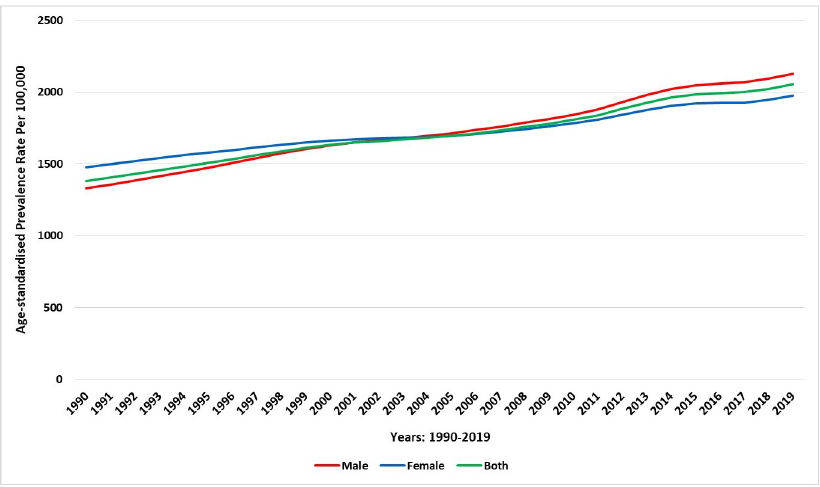
Fig 1. Trends in the age-standardised prevalence rate of COPD during 1990–2019 in Saudi Arabia, stratified by gender.